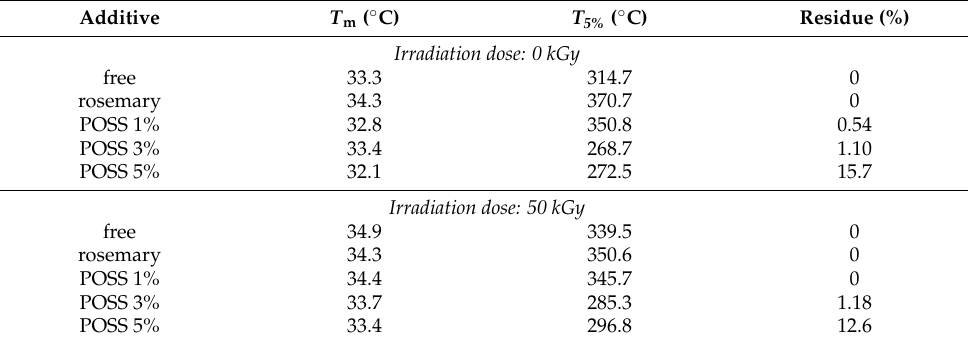
Table 1. Melting temperatures ( T m ), temperatures at 5% mass loss ( T 5% ) and residue % at 700 ◦ C determined on EPDM